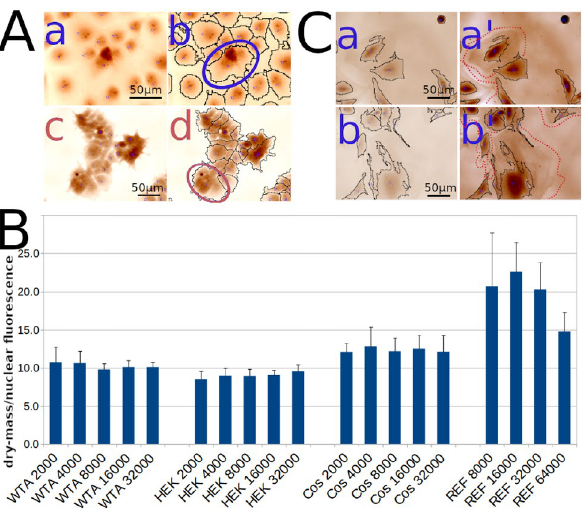
Figure 2. ( A ) Image a: Cos cells, segmented in b. The width of the picture is approximately 200 µm. Image c: HEK cells, segmented in d. The pictures are approximately 300 µm in width. For both Cos and HEK cells, some segmented areas encompass more than a single cell, as illustrated in the drawing of the 2 ellipses. However, for both cell types, all the cells present in the fields are within the segmented areas. ( B ) Bar graph representation of the ratio "integrated dry mass /integrated nuclear fluorescence intensity" for 4 different cell types at different plating concentrations. The error bars are the standard deviations calculated from the average of the Summed Dry mass/Total fluorescence ratios of all matching interferograms/fluorescent cell images analyzed in each of the 19 conditions presented in this experiment (4 cell types and 5 plating densities, except REF: 4 plating densities). There were from 12 to 24 independent interferograms/fluorescent images analyzed for each of the 19 conditions presented. Number of cells analyzed are shown in Supplementary Information, Table S1. ( C ) 2 examples of REF cell incomplete segmentation. a’ and b’ are contrasted version of a and b, respectively, where we can see that the cell periphery is barely detectable (circled with red dashed line). The picture field width is approximately 300